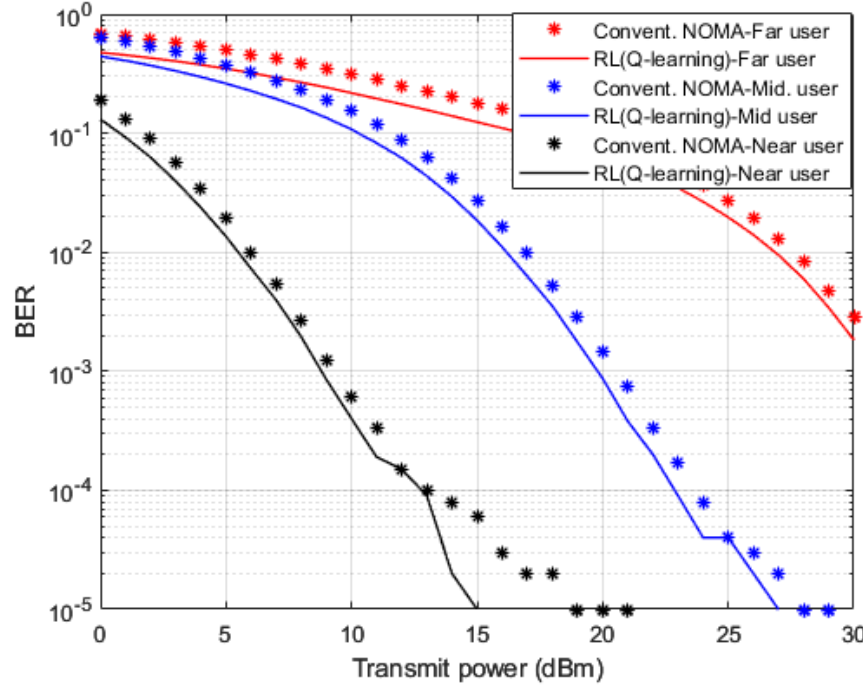
Figure 12. BER vs. Power ( Q -learning, Conventional NOMA (MMSE)—Rician channel).